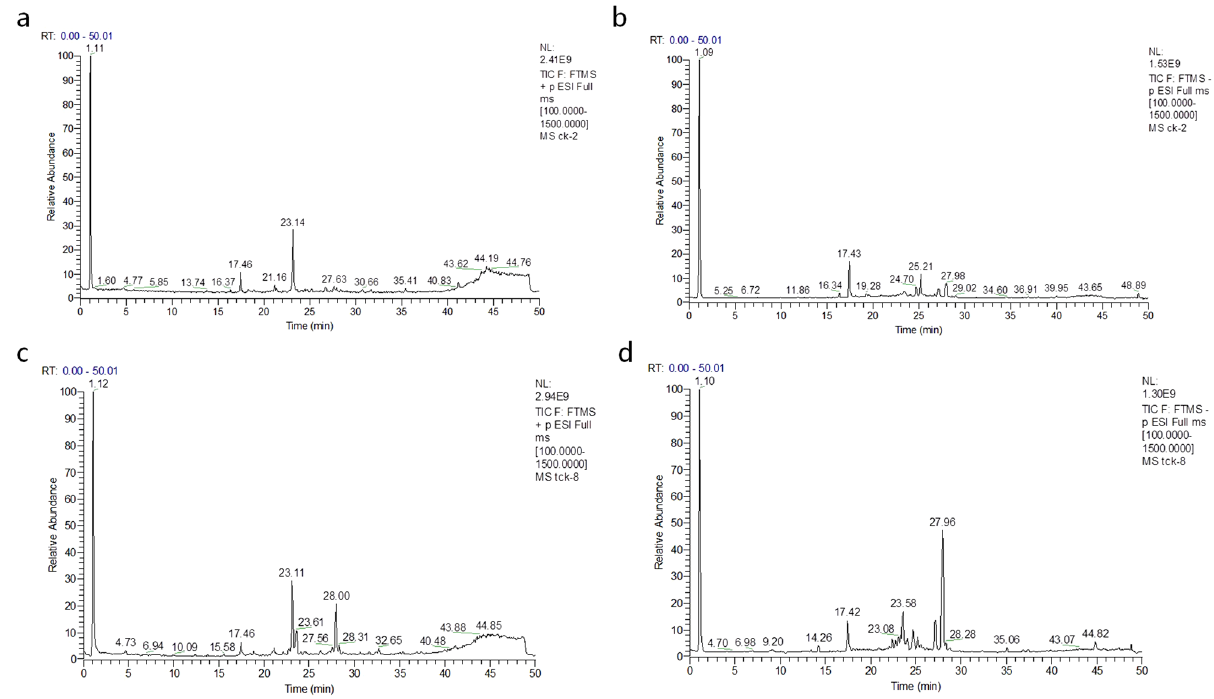
Figure 1. LC–MS chromatograms of the wheat grain metabolites (X-axis = time and Y-axis = response. ( a ) Relative abundance of positive ions at different time intervals for control. ( b ) Relative abundance of